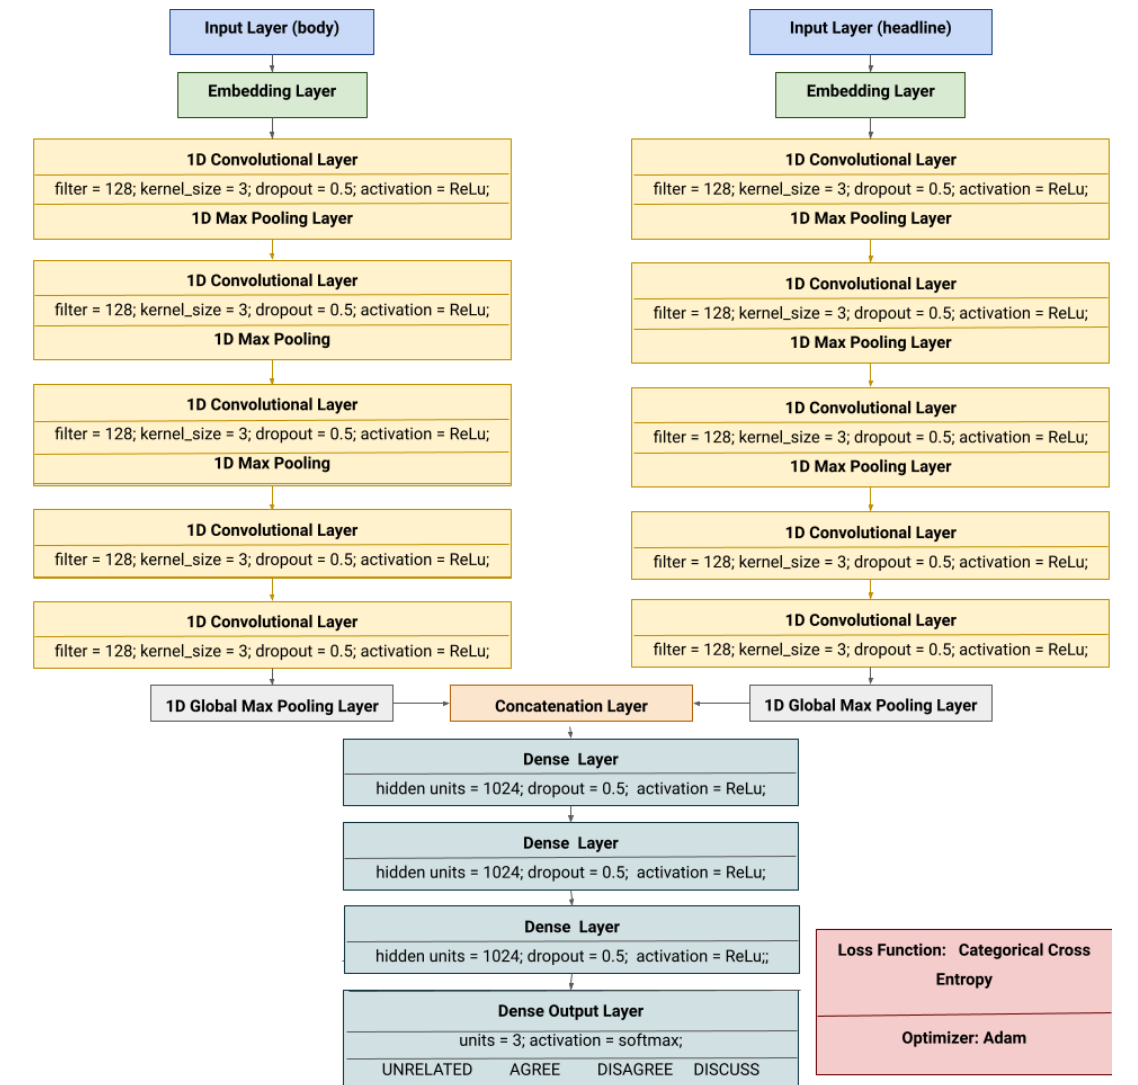
Figure 3. In the figure the architecture of the convolutional network for stance classification. The net- work has two inputs, one for the headline (the claim to be verified) and the other for the body (the similar document). The embedding layer is taken from the trained doc2vec model. The two branches have the same number of convolutional layers interleaved by pooling layer and the last layer is global max pooling, that takes the maximum value over the time dimension. The two branches are then concatenated and passed through three dense layers with reLu activation and finally the output layer with three neurons and Softmax activation function for multi-class